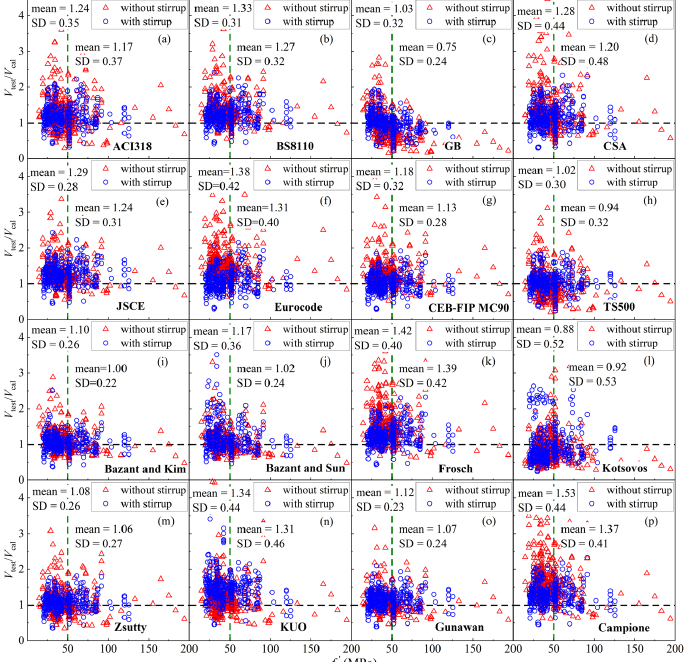
Figure 12. The relationship between the ratios ( V test / V ca l ) and concrete strength of ( a ) ACI318; ( b ) BS8110; ( c ) GB; ( d ) CSA; ( e ) JSCE; ( f ) Eurocode; ( g ) CEB FIP MC-90; ( h ) TS500; ( i ) Bazant–Kim; ( j ) Bazant–Sun; ( k ) Frosch; ( l ) Kotsovos; ( m ) Zsutty; ( n ) Kuo; ( o ) Gunawan; ( p ) Campione.